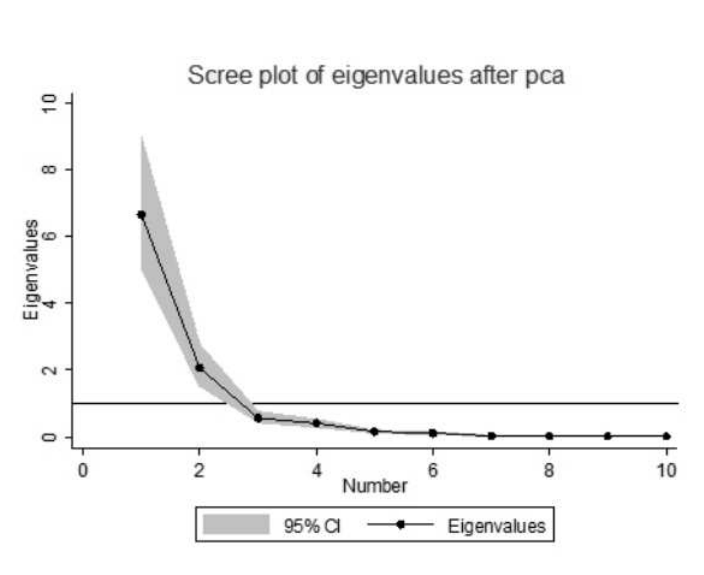
Figure 5. The scree plot of the